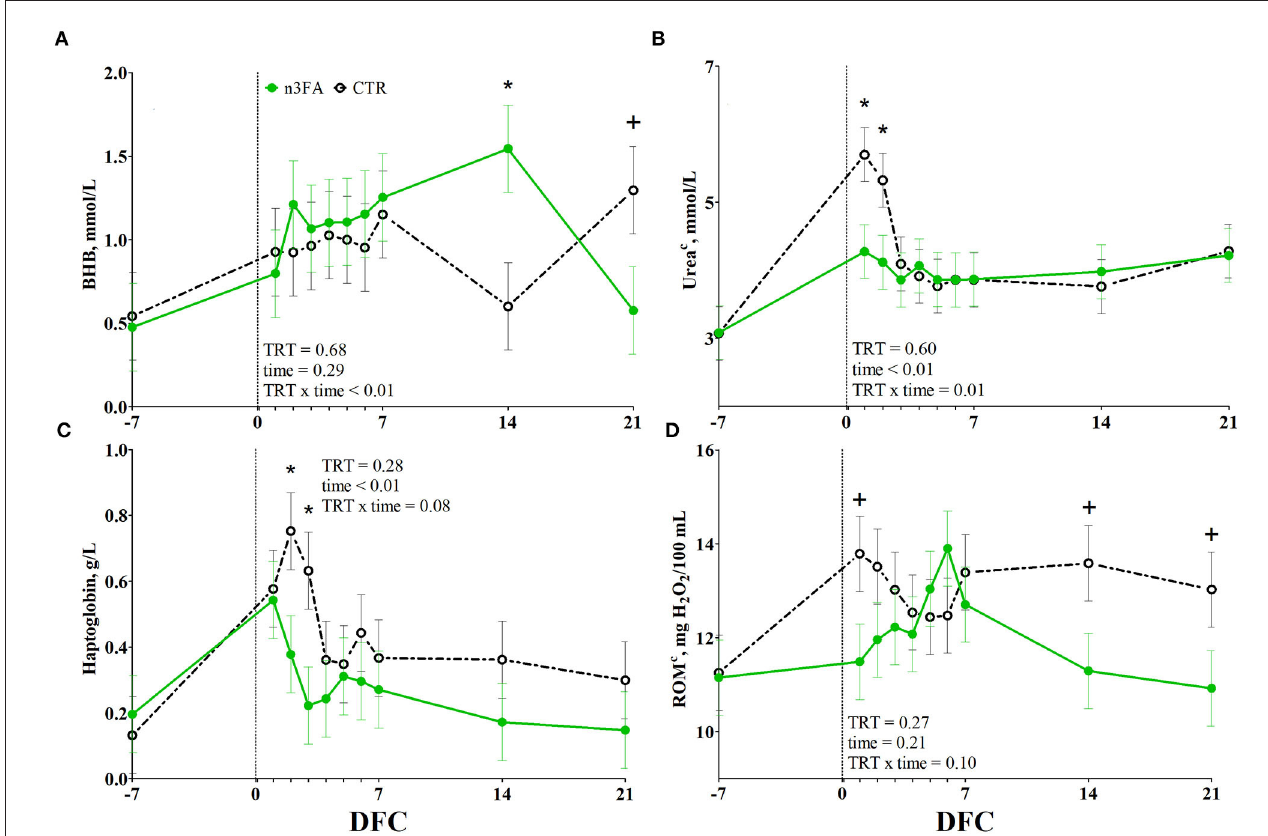
FIGURE 4 | Time course of plasma concentrations of beta-hydroxybutyrate ( BHB ; A ), urea ( B ), haptoglobin (C) , and total reactive oxygen species ( ROMt ; D ) in dairy cows infused with 150ml of sterile saline (CTR; black dotted line) or 150ml of a 10% solution containing purified fish oil rich in long-chained omega-3 fatty acids (n3FA; green solid line) at 12, 24, and 48h after calving. TRT is treatment effect; TRT x time is treatment x time interaction effect (* is P < 0.05; + is P < 0.10), c parameter was covariate on − 3 DFC